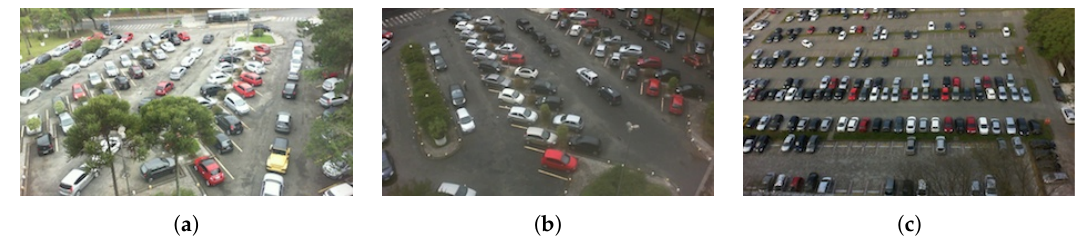
Figure 6. Parking lots used in PKLot database ( a ) Federal University of Parana; ( a ) Federal University of Parana, captured from 4th floor of the building; ( b ) Federal University of Parana, captured from 5th floor of the building; ( c ) Pontifical Catholic University of Parana, captured from 10th floor of the building.